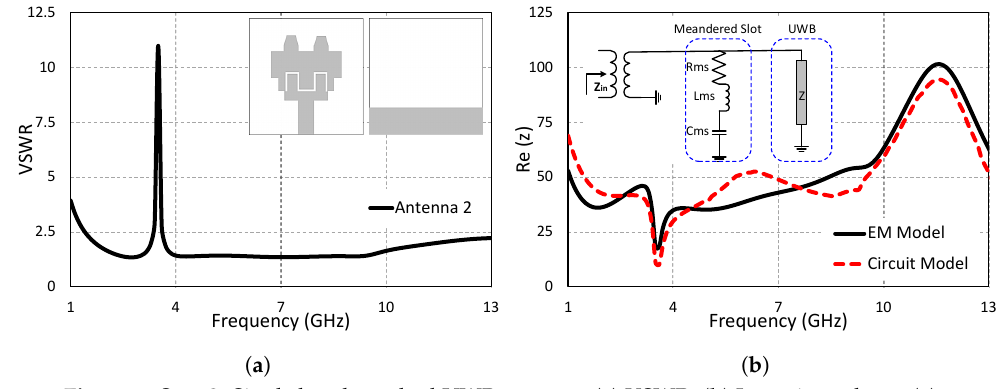
Figure 3. Step 2: Single band-notched UWB antenna. ( a ) VSWR. ( b ) Input impedance